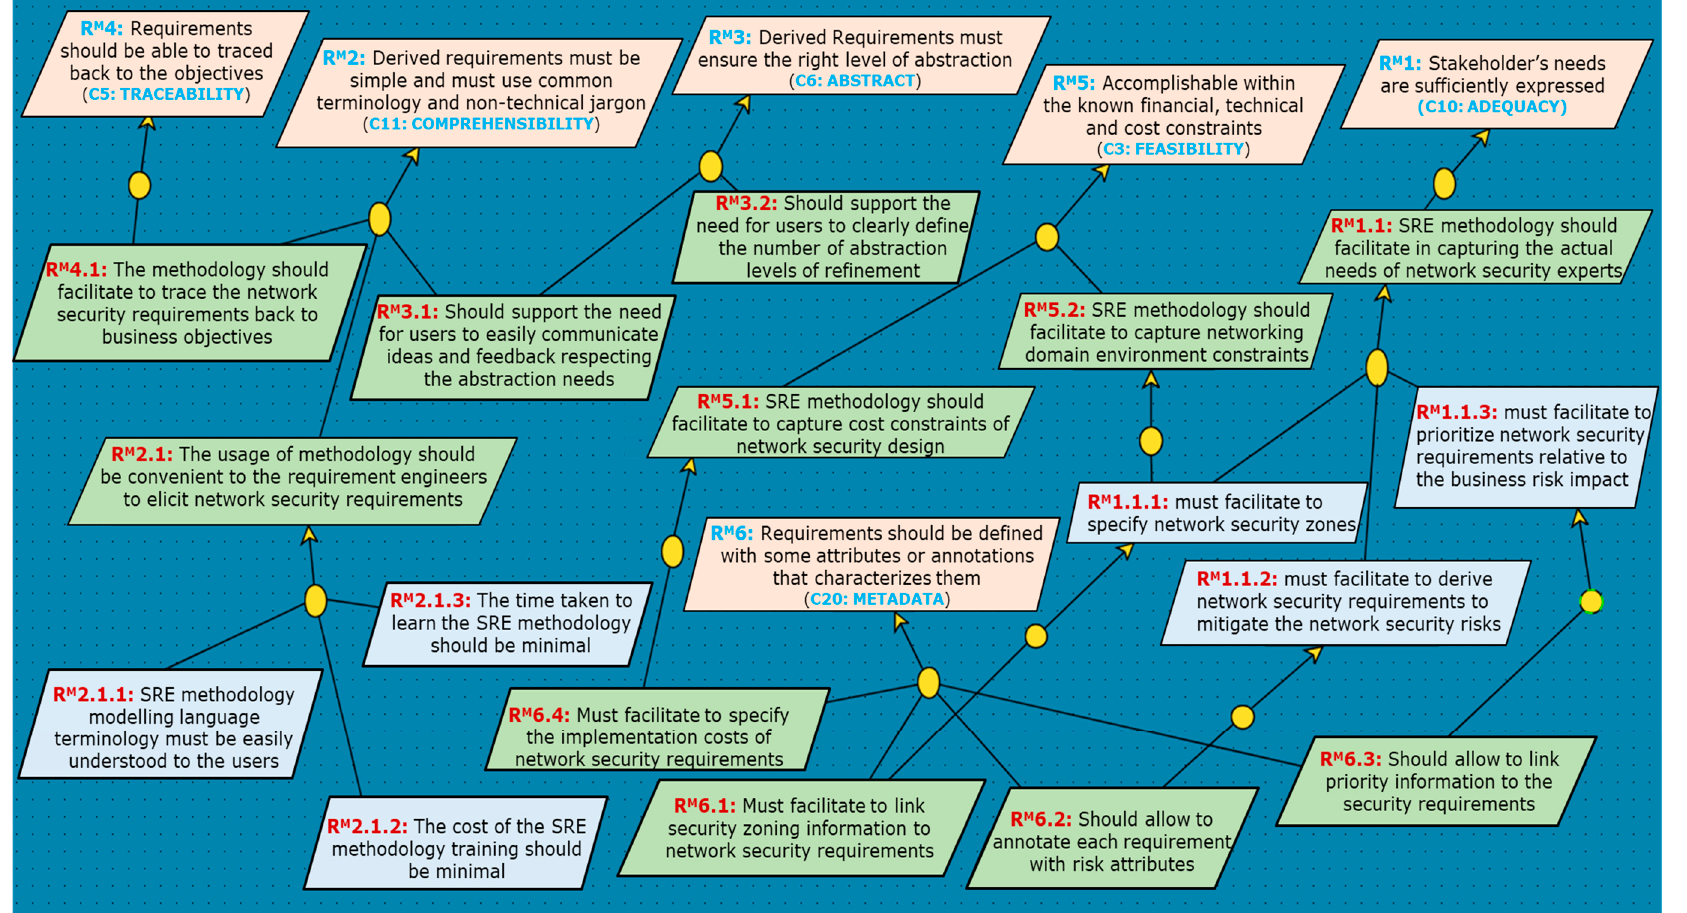
Figure 4. SRE-methodology-to-be goals refinement (Sample).